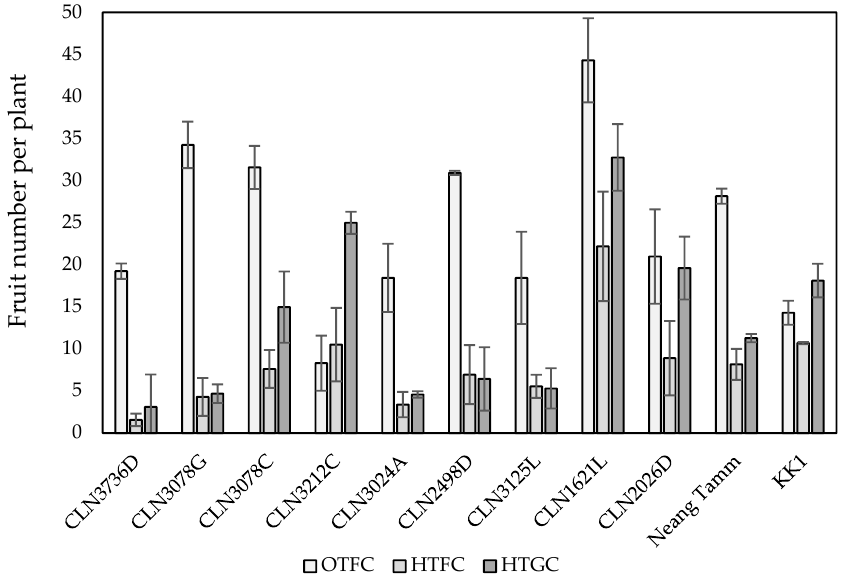
Figure 2. Fruit number per plant of tomato genotypes under optimal temperature field condition (OTFC), high temperature field condition (HTFC), and high temperature greenhouse condition (HTGC). Value is the mean of three replications with the error bars which represent standard de- viation.